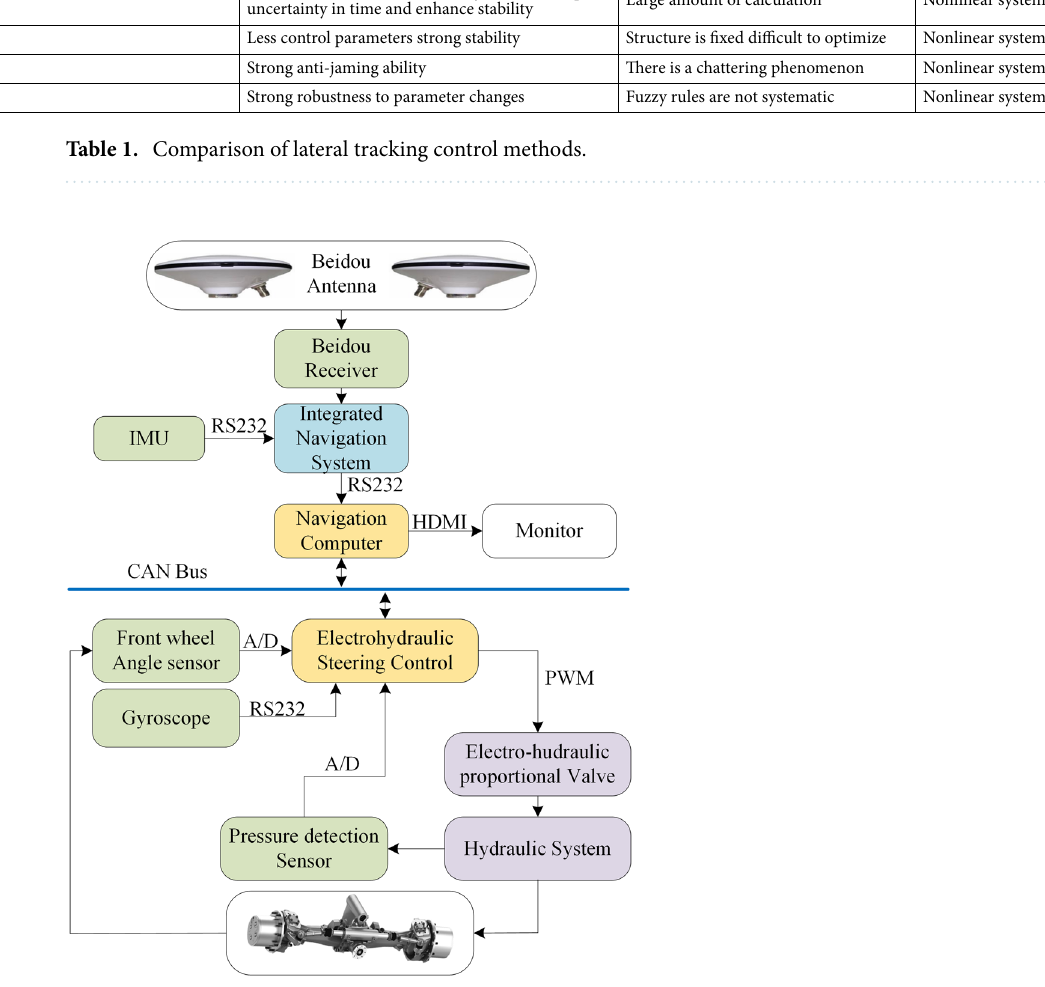
Figure 1. Hardware architecture of an autonomous